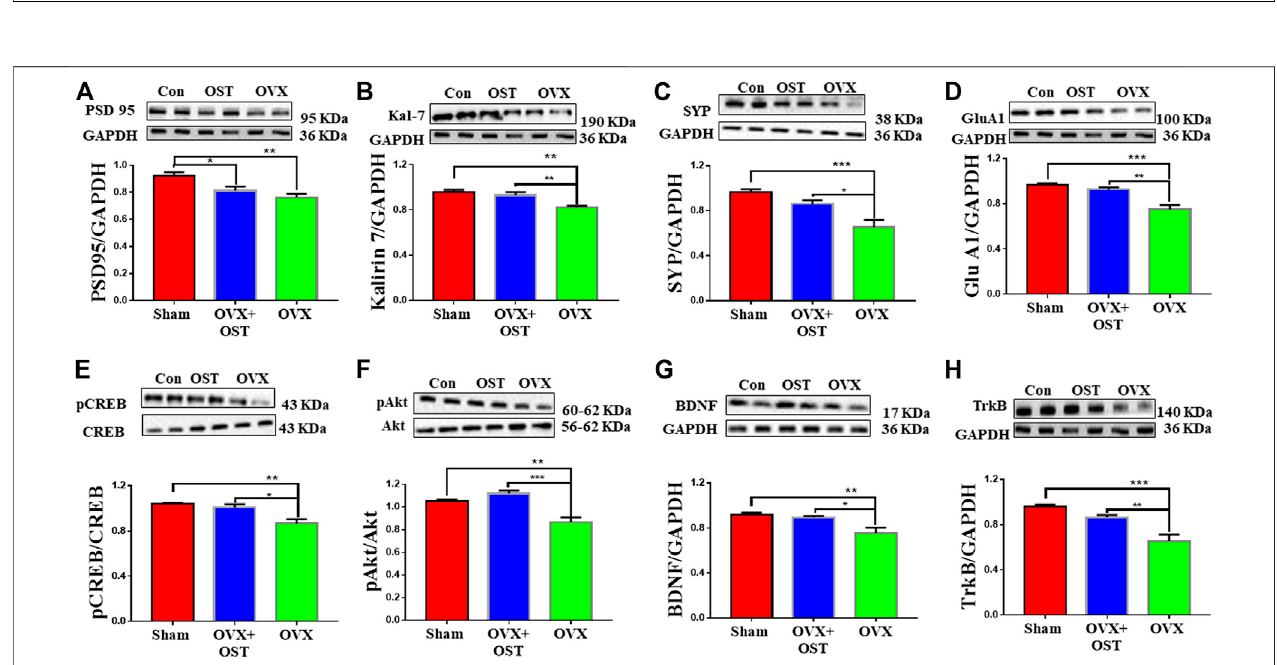
FIGURE5| EffectsofOSTonOVX-inducedalterationsinthelevelsofsynapticproteins (A – D) andotherproteins (E – H) inthemousehippocampus.Expressionsof PSD 95 (A) , Kalirin 7 (Kal-7) (B) , synaptophysin (SYP) (C) , GluA1 (D) , pCREB/CREB (E) , pAkt/Akt (F) , BDNF (G) and TrkB (H) were assessed by Western blot analysis. OVXcausedadecreaseinthelevelsofallproteins.TreatmentwithOSTcausedasigni fi cantincreaseinthelevelsofalltheseproteinswiththeexceptionofPSD95inthe hippocampus of the OVX group compared with the OVX + OST (OST) group. Data are represented as mean ± SEM ( n (cid:1) 5). * p < 0.05; ** p < 0.01; *** p < 0.001.